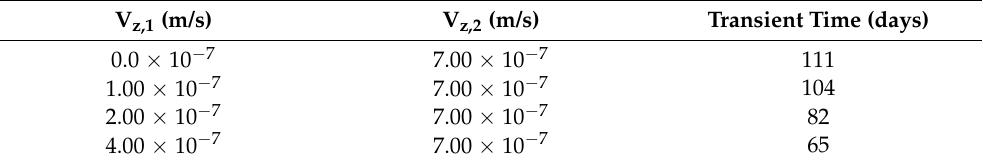
Table 5. Transient time simulated as a result of a change in vertical